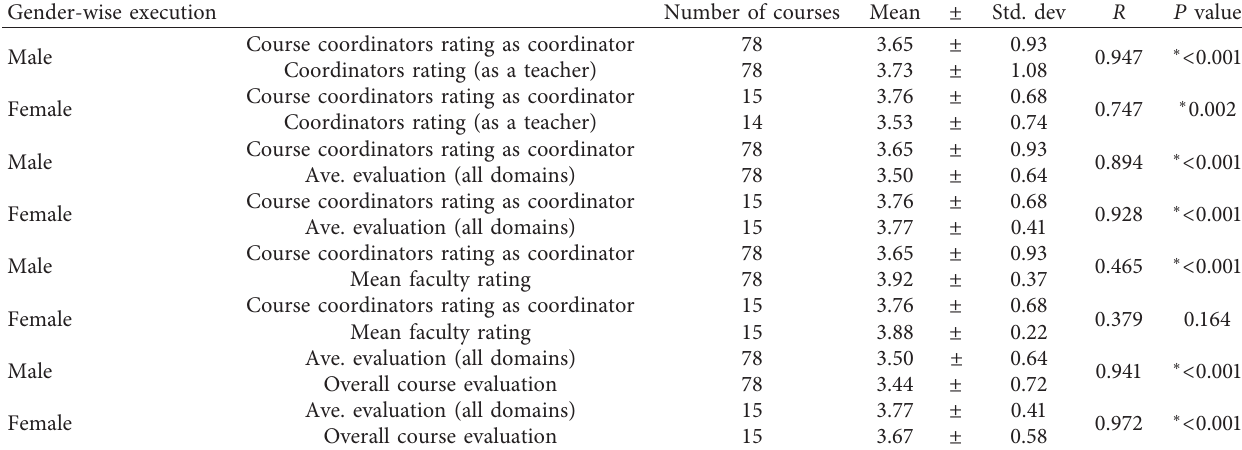
Table 3: Association and difference based on sectional execution of courses in male and female parts of the